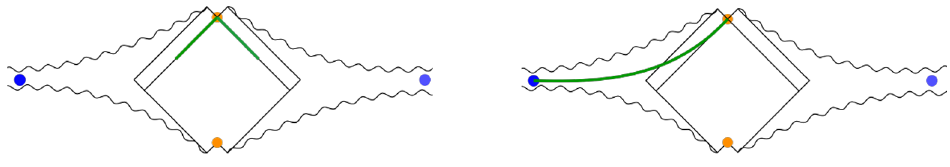
Figure 6 . Two types of island complements, C drawn as green lines in the geometry with backre- action (4.1) at high temperature. Left: C of a type I island which only contains the cosmological horizon. Right: C of a type II island which approximately connects the black hole apparent horizon and cosmological apparent